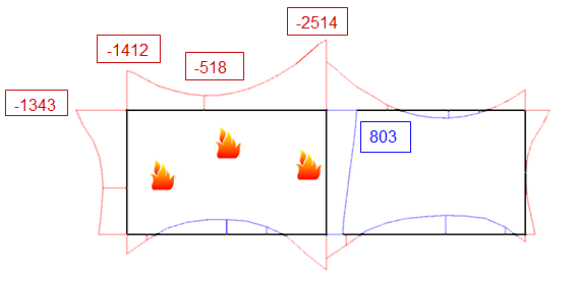
Figure 6. Bending moment diagram for t = 30